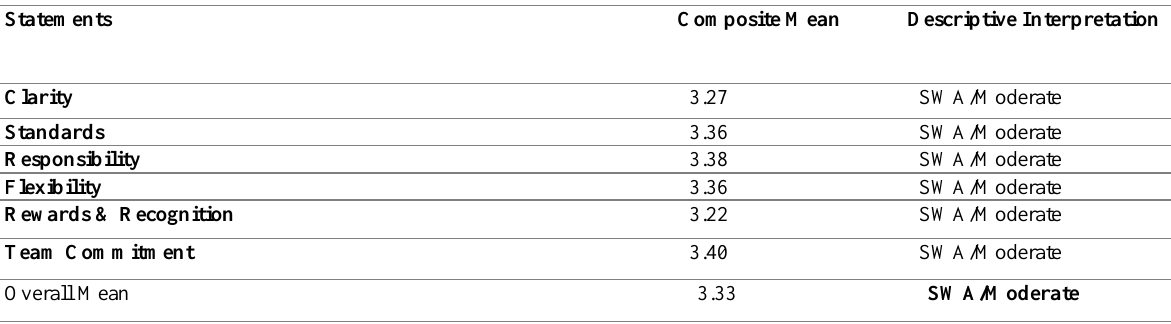
Table 7: Organizational Climate Summary